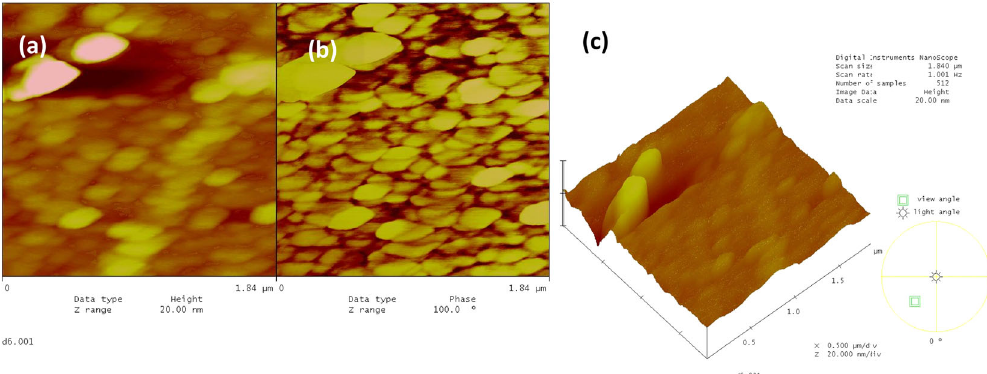
Fig. 4 The AFM images of the fi broin fi lm on glass substrate, ( a ) 2-dim. topographical, ( b ) phase, and ( c ) 3-dim. topographical images, 1.84 × 1.84 μ m.